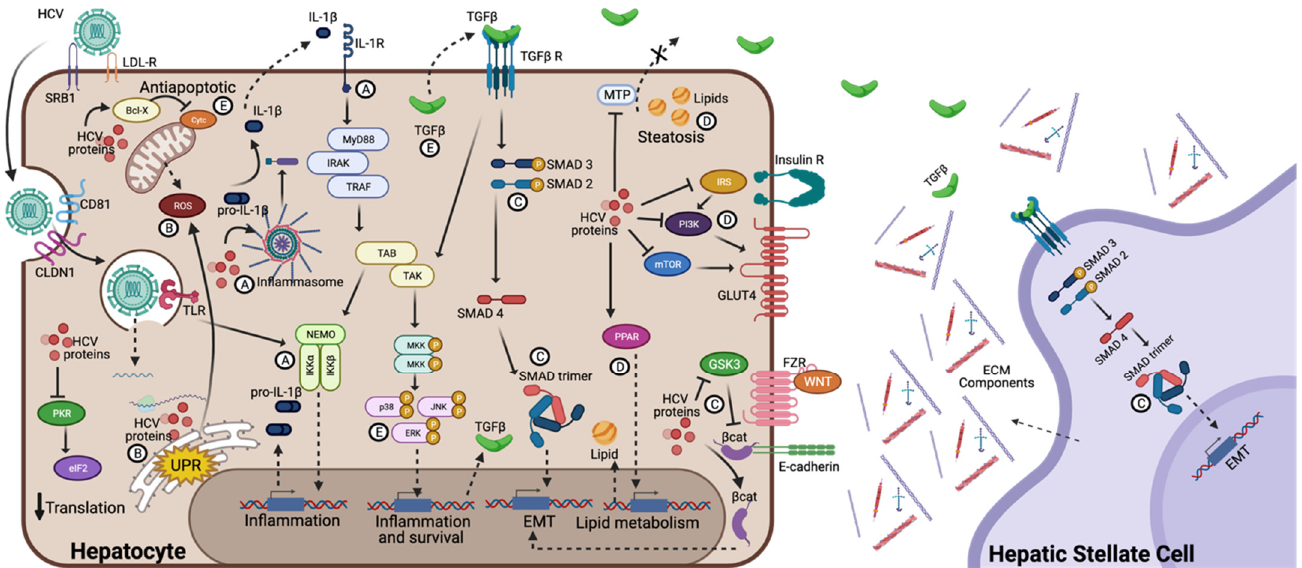
Figure 2. Molecular signaling pathways involved in HCV-induced hepatocarcinogenesis develop- ment. The binding and endocytosis of the HCV virus to the hepatocyte is mediated by the LDLr, CD81, and the SRB1 interaction with E1/E2 heterodimer. Once in the endosome, the HCV RNA release into the cytosol for translation and replication. The translation generates the polyprotein, and once the viral proteins are generated they can trigger diverse molecular signaling pathways, such as inflammation, by TLR and inflammasome activation ( A ); oxidative and ER stress, induced by ROS and UPR, respectively ( B ); EMT, through activation of TGF- β pathway on hepatocytes and hepatic stellate cells, and regulation of Wnt/ β -catenin pathway ( C ); steatosis and insulin resistance, by inhibition of MTP and insulin receptor pathways ( D ); and proliferation and apoptosis resistance by survival expression genes and antiapoptotic proteins induction ( E ). All these simultaneous pathways induced by HCV proteins are involved in hepatocarcinogenesis development.